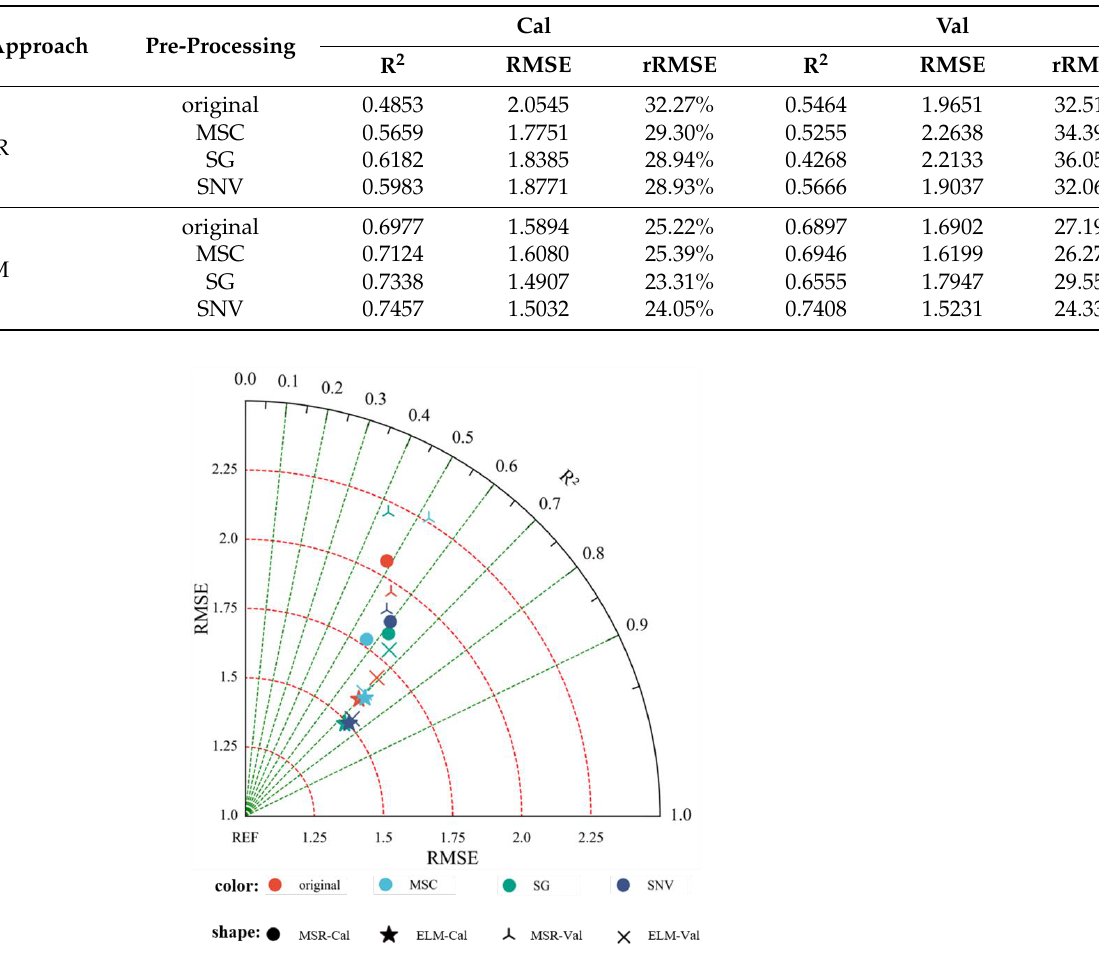
Table 7. Cotton LAI monitoring model result based on vegetation indices.